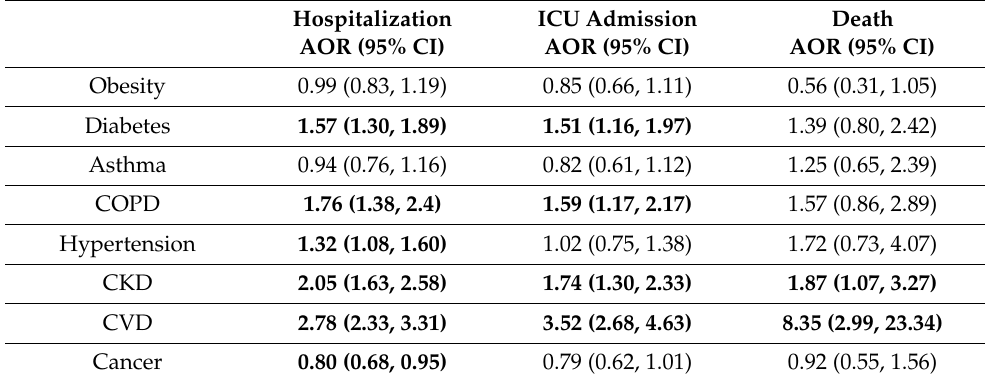
Abbreviations: COPD, chronic obstructive pulmonary disease; CKD, chronic kidney disease. Models mutually adjusted for age, sex, race/ethnicity, and comorbidities: obesity, type 2 diabetes, asthma, COPD, hypertension, CKD, CVD, and cancer or history of cancer. Bold indicates significant associations, p <